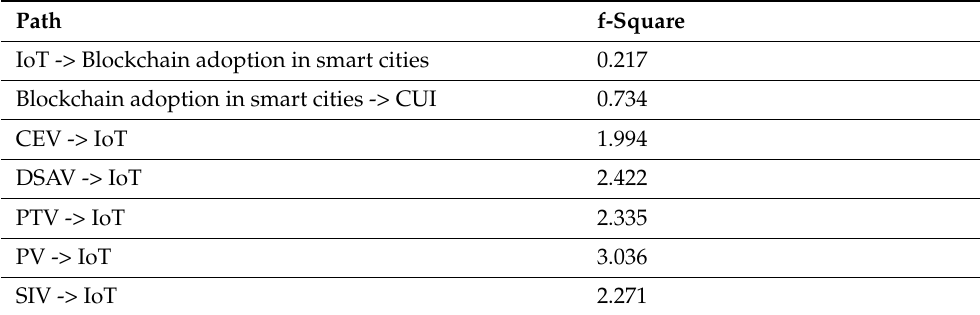
Table 2. Structural Model Effect Size f2